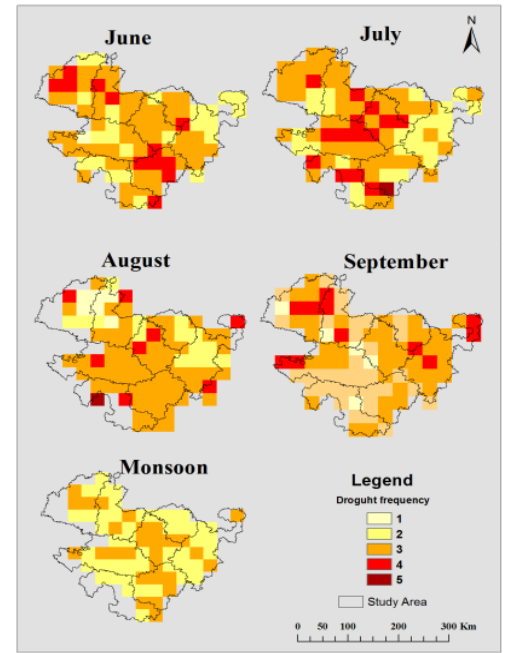
Figure 5. Month-wise number of years under meteorological